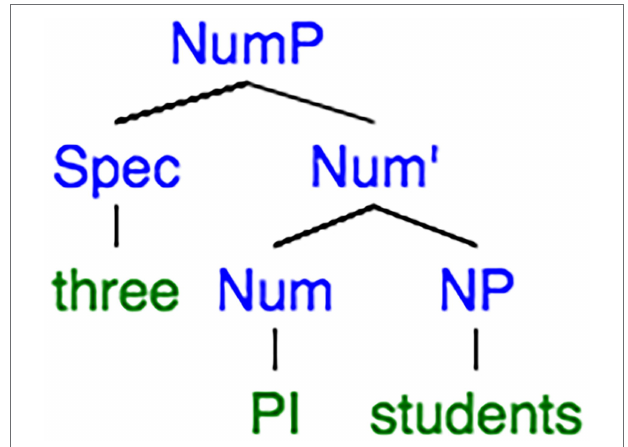
FIGURE 2 | Syntactic tree extracted from Li (1999, p. 87).